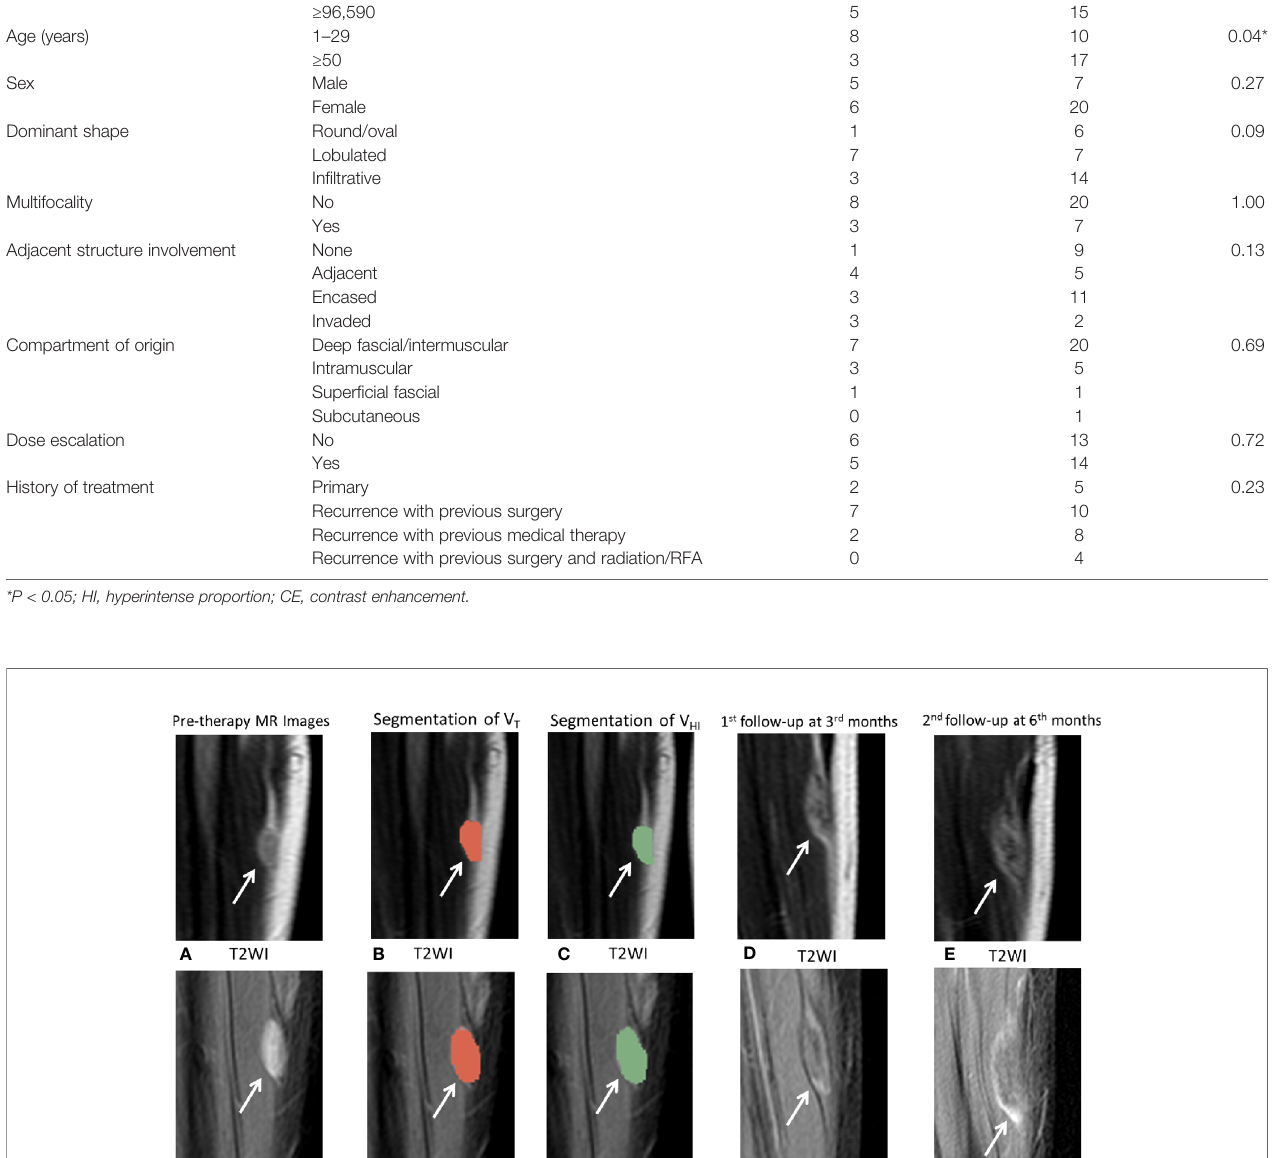
HI on T1 CE <75% HI on T1 CE ≥ 75% P (n = 11) (n = 27)